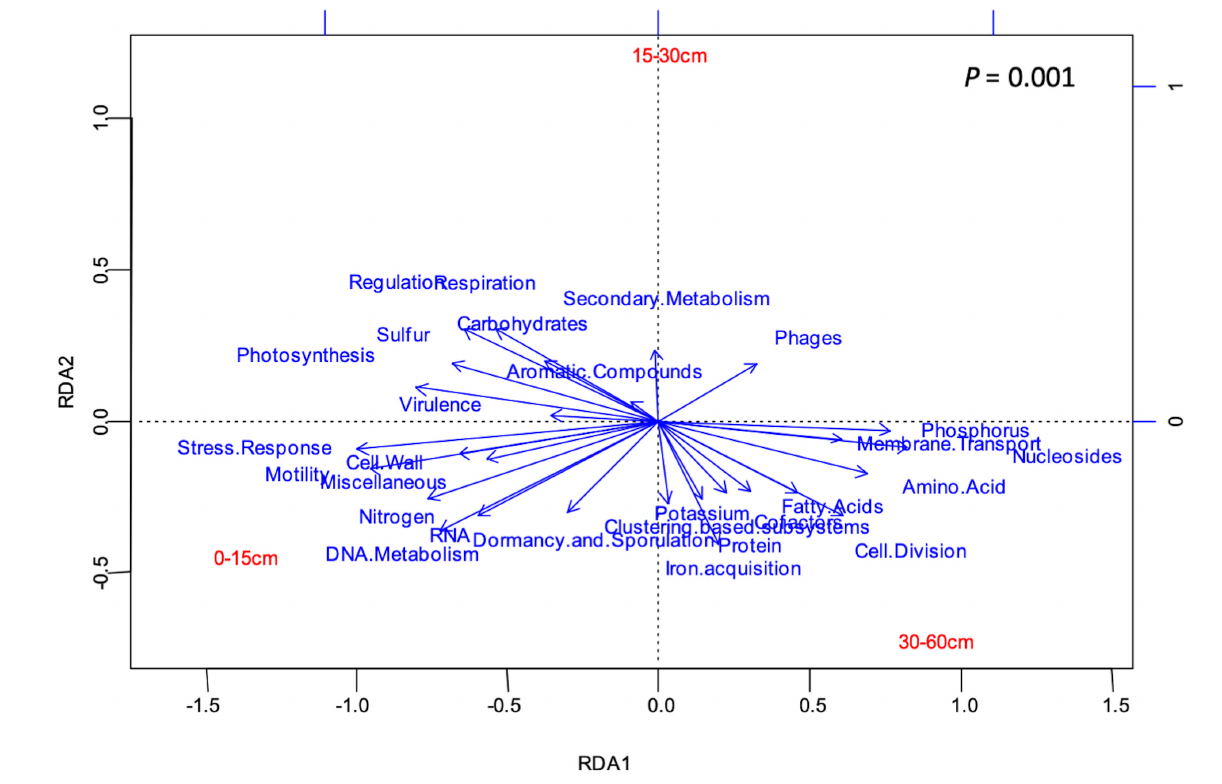
FIGURE 3 | RDA showing the relationship ( p = 0.001) between soil depth and 28 functional categories of subsystems level 1. Narrow angles between the vectors of soil depth and a functional category indicate a strong positive relationship, a wide angle, shows a negative relationships, and a 90 ◦ angle shows the absence of relationship. Long vectors indicate that the functions are well represented in the